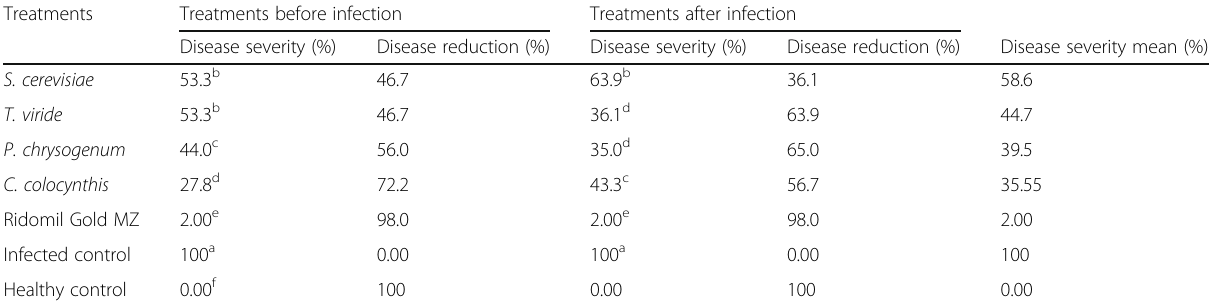
Table 4 Effect of different treatments with bioagents on disease severity (%) of BOUB caused by Botrytis allii under greenhouse